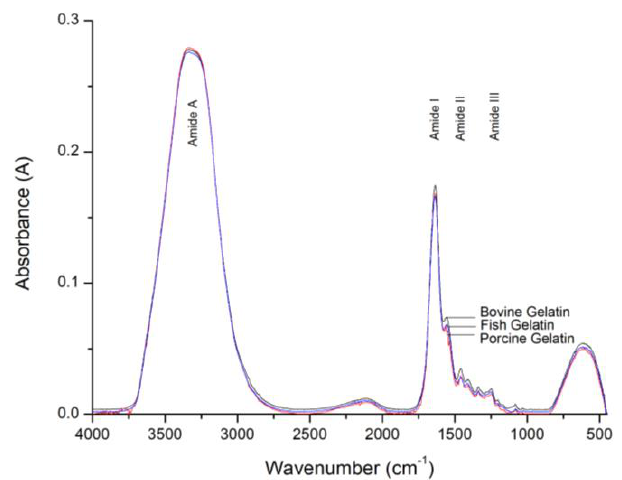
Figure 1. FTIR spectra of bovine, porcine and fish gelatins.